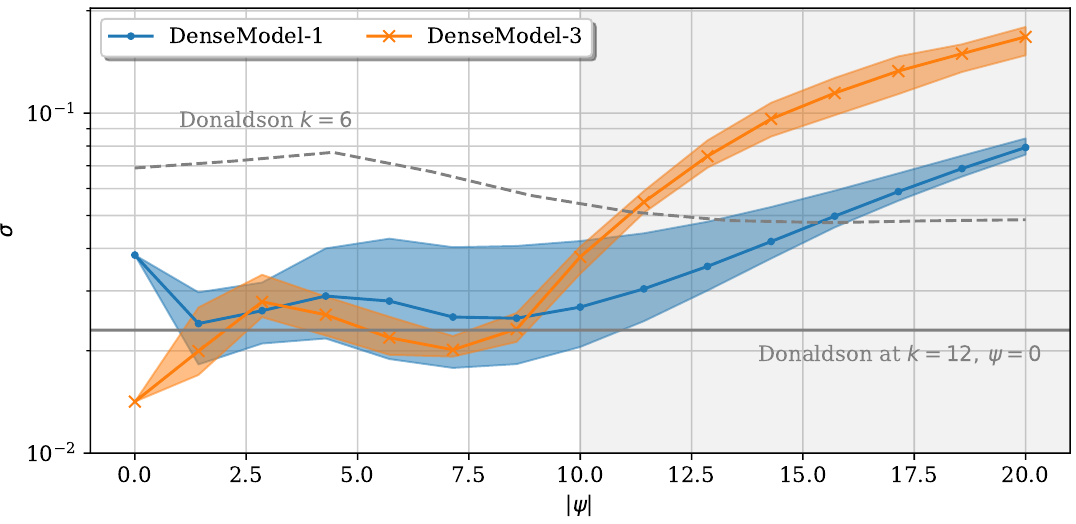
Figure 12 . Accuracies achieved by two network architectures detailed in section C.5 trained over uniform values | ψ | < 10 using the MA loss. The shaded area points out the extrapolation of the networks. As a comparison, the σ accuracies achieved by Donaldson’s algorithm over real values of ψ are shown. The error band indicates the minimal and maximal values measured over multiple complex